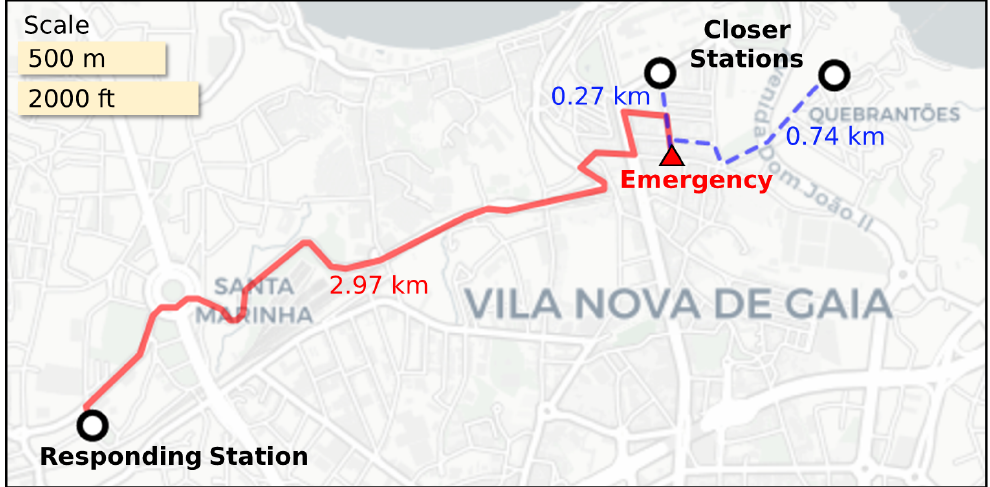
Figure 1. Example of a potential inefficiency: a farther station responded to an emergency despite having two other stations that are closer to it. Map and routes are based on